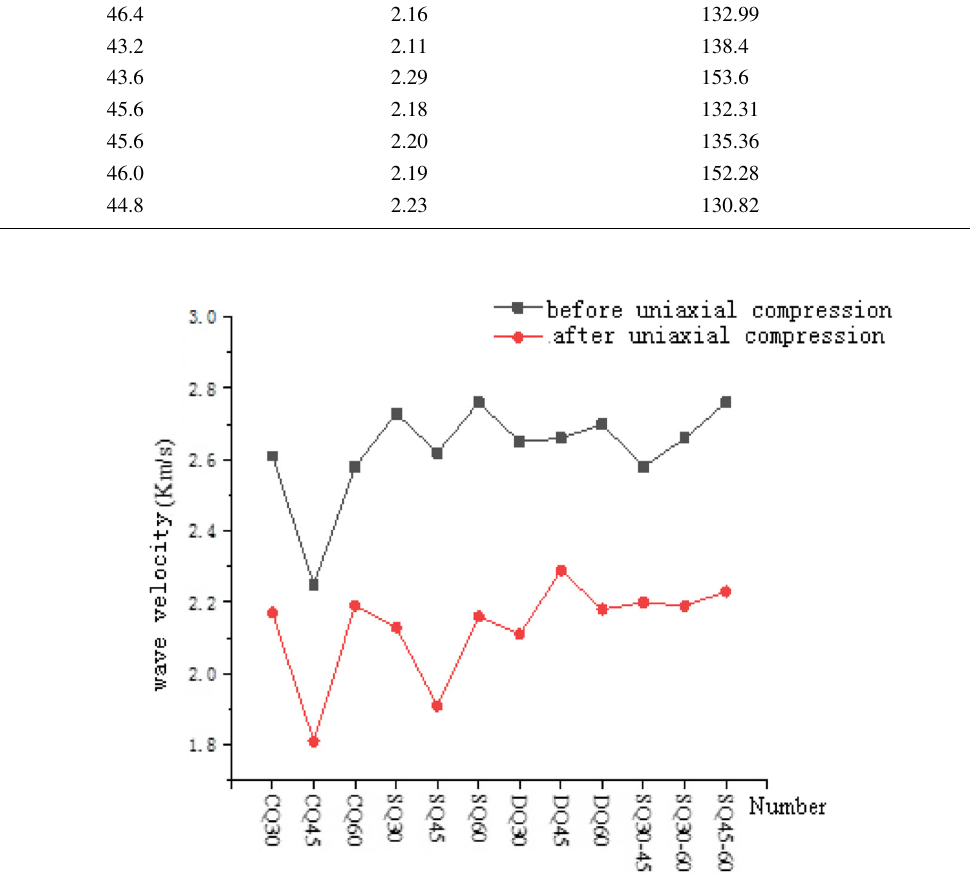
Fig. 9 Wave-velocity curves, before (black square) and after (red circle) the uniaxial compression